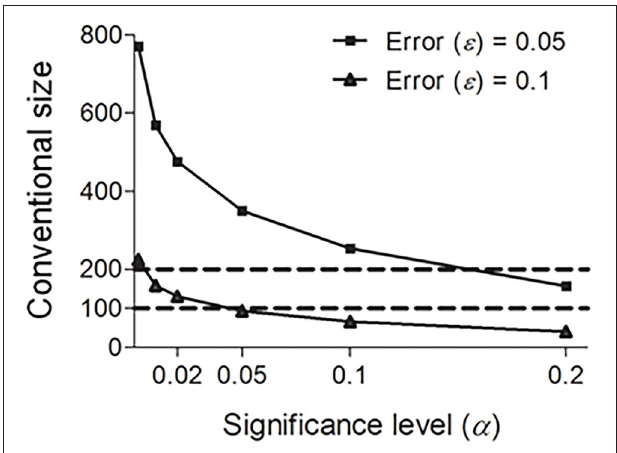
FIGURE 3 | Conventional size n under fixed error rates ε (0.05 and 0.1) and total vocabulary size N (4000), and various significance levels α